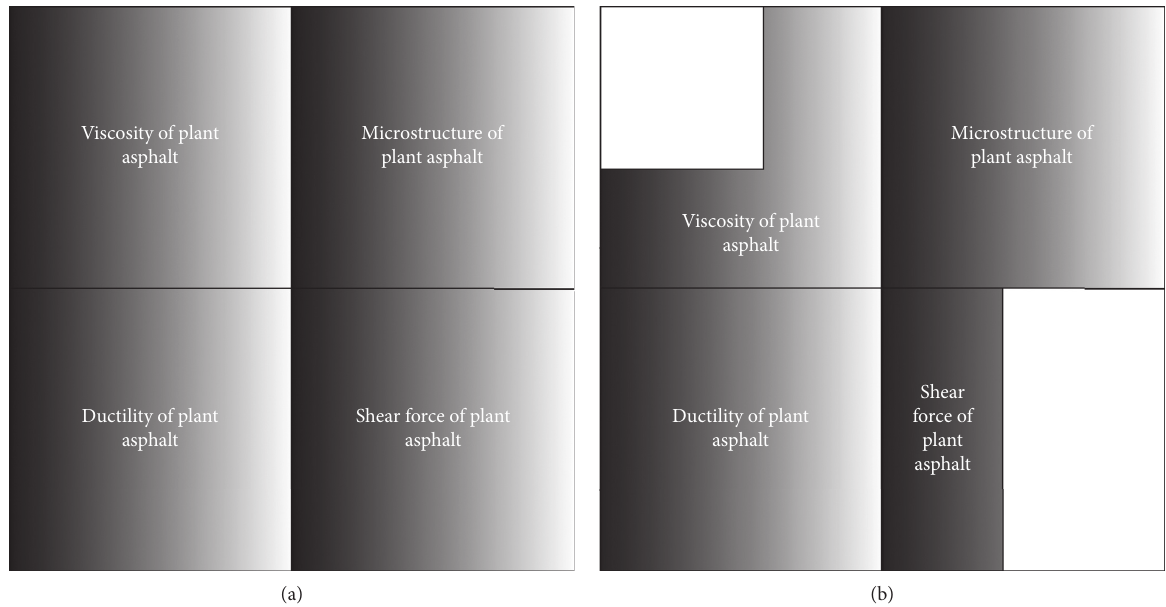
Figure 10: Comparison results between design method analysis index and original method analysis index. (a) Analysis index of design method in this paper. (b) Original method analysis index.